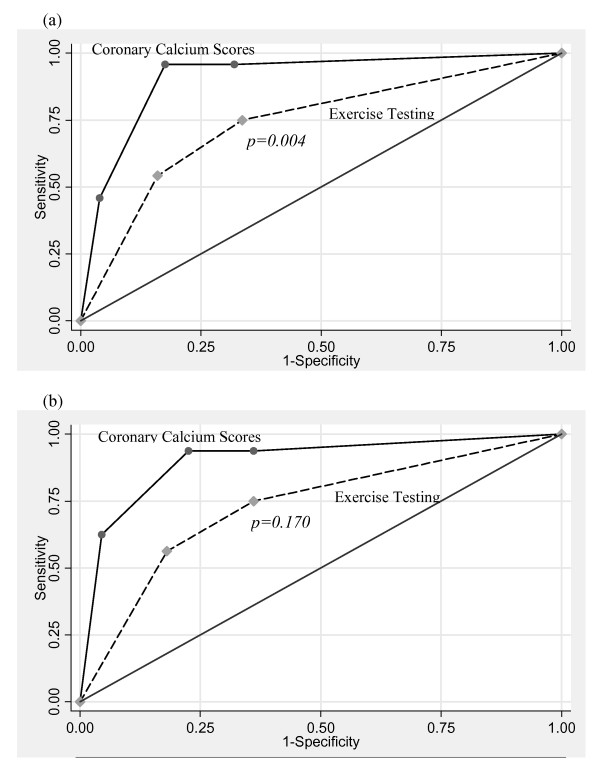
Receiver operator characteristic curves. (a) primary endpoint (documented significant obstructive coronary artery disease) Area under the curve for coronary calcium scores 0.91 (95% CI 0.84–0.97); Area under the curve for exercise test 0.74 (95% CI 0.64–0.83). (b) secondary endpoint (Class I or IIa indication for revascularization procedure) Area under the curve for coronary calcium scores 0.90 (95% CI 0.78–1.00); Area under the curve for exercise test 0.73 (95% CI 0.52–0.93)